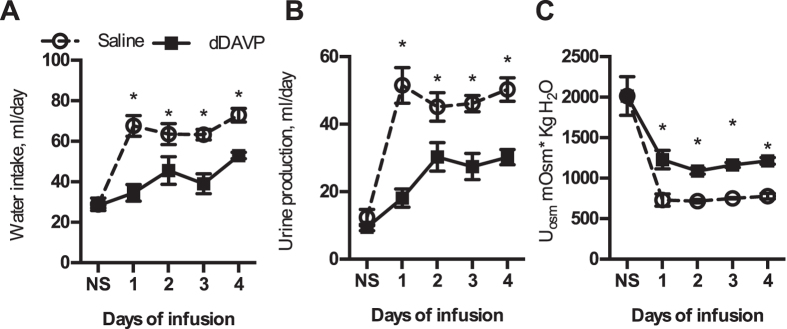
Chronic renal intramedullary interstitial infusion of saline, or dDAVP with implantable, peristaltic pumps.Rats were switched from a normal salt (NS) to high salt diet plus intramedullary infusion. dDAVP intramedullary, interstitial infusion resulted in a significant reduction in (A) water intake and (B) urine production compared to saline infused control rats (n = 4 rats/group, solid line). (C) Urine osmolality was significantly increased with dDAVP interstitial infusion, compared to saline infused rats (dotted line). *Represents P < 0.05 compared to vehicle infused rats from repeated measures, Two Factor ANOVA analysis.